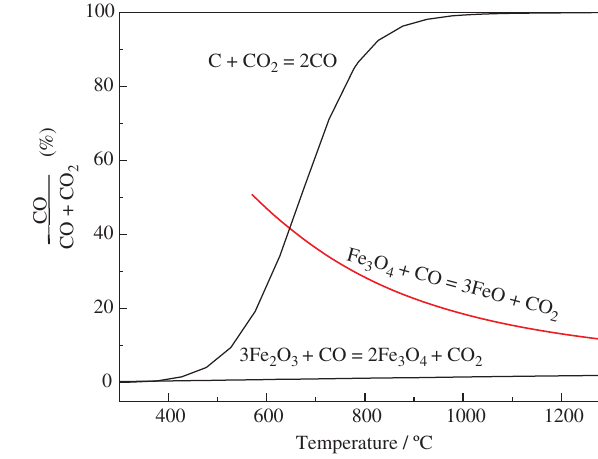
Figure 2: Effect of coke fines dosage on compressive strength at different preheating temperature (Preheating for 15 min).